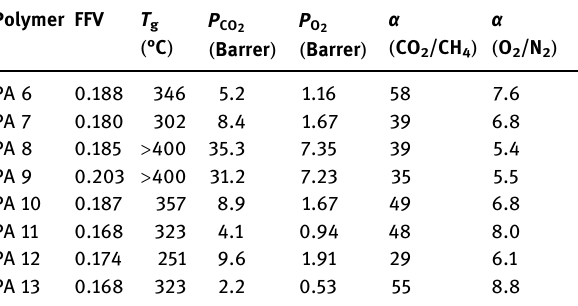
Table 3: FFV, T g , and gas permeability ( in Barrers ) and permselec - tivity values of the PAs having indene moiety measured at 30°C and 1 – 2 atm upstream pressure ( 61 ) Polymer FFV